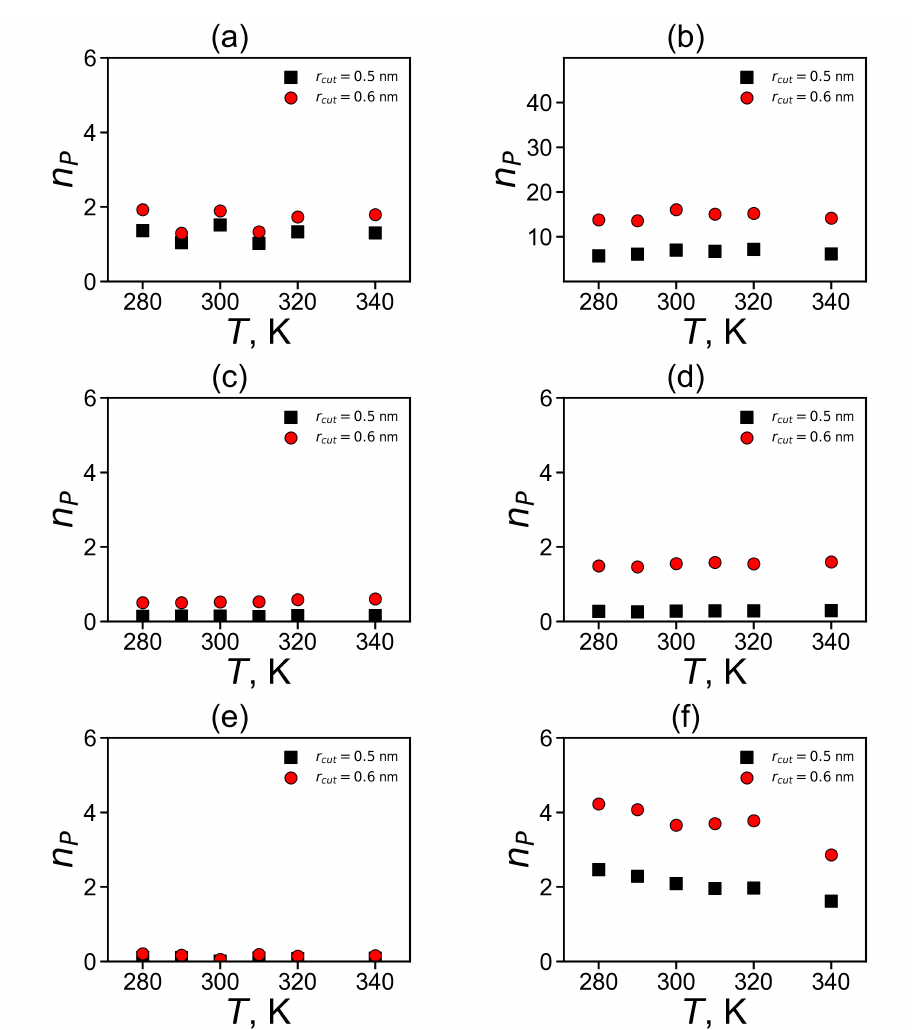
Figure 12. The average number of pairs for imidazole–imidazole (or guanidine–guanidine) groups at different temperatures ( a , c , d ) for pairs between neighboring groups and ( b , d , e ) for pairs between non-neighboring groups in Lys–2His ( a , b ), Lys–2Hisp ( c , d ) and Lys–2Arg ( e , f